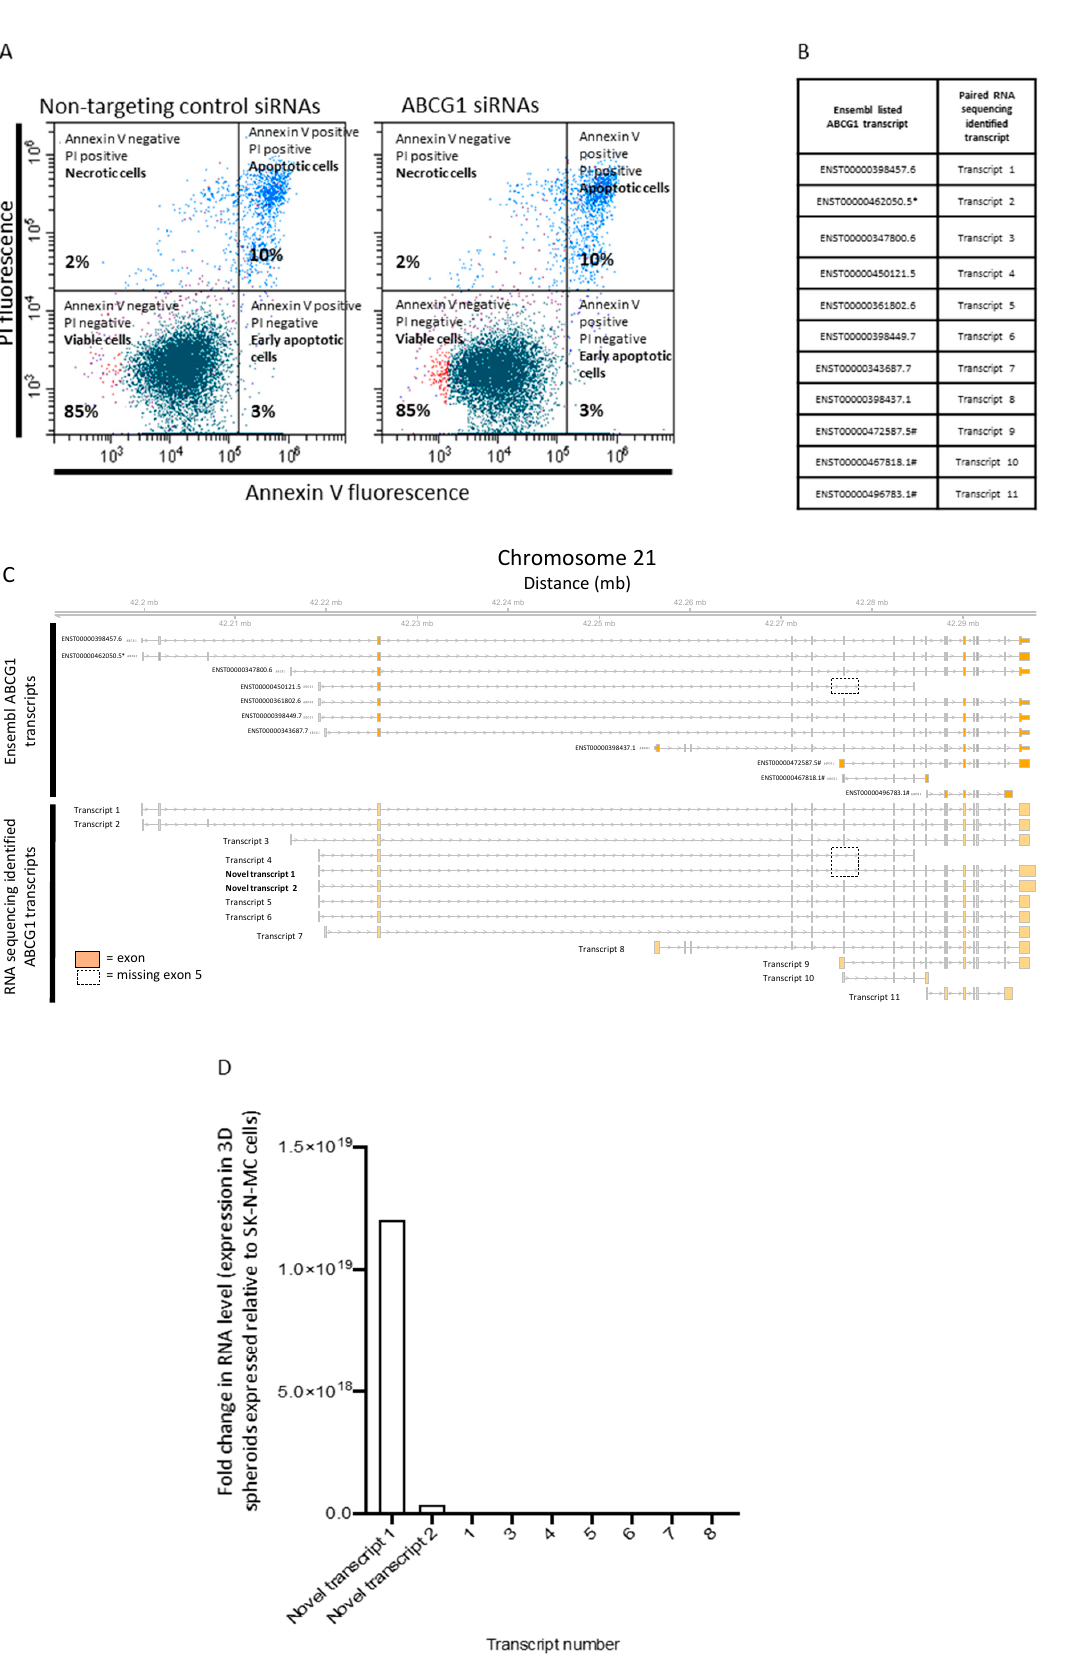
Figure 5. Functional role and characterisation of ABCG1 in ES. ( A ) Representative dot plot of annexin V and PI labelling of SK-N-MC cells analysed by flow cytometry following knockdown of ABCG1